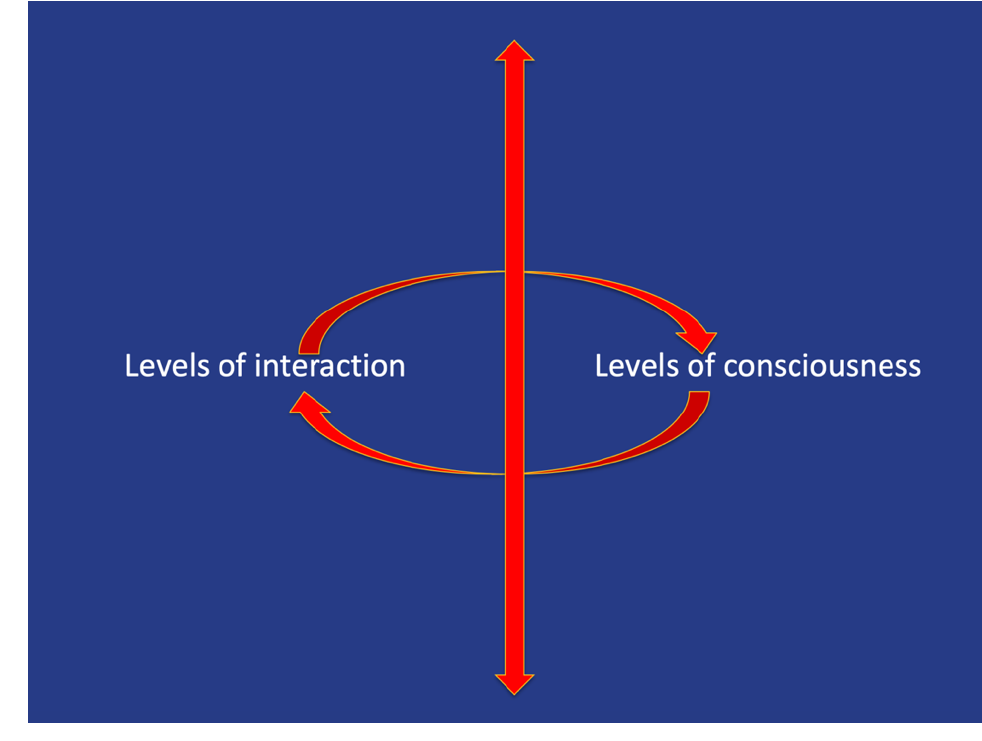
FFigigururee 1111 Levels of Interaction and Levels of